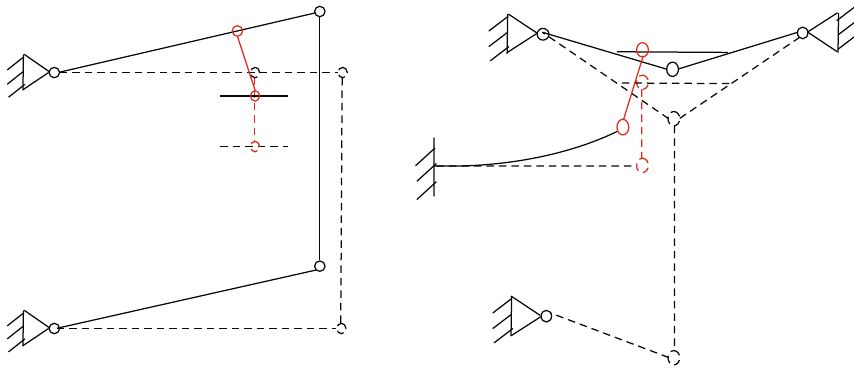
Figure 3: Schematic of the kinematic of the suspension, the rod is depicted in